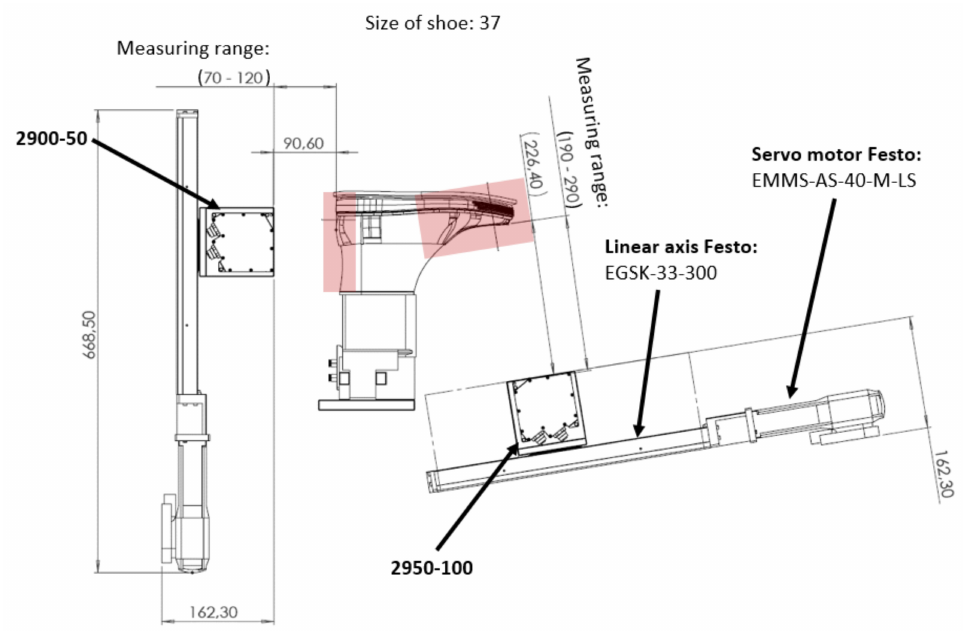
Figure 9. Concept of inspection